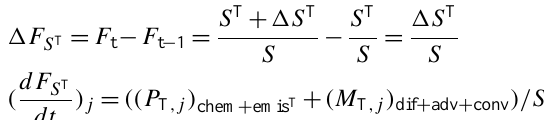
Fig. 1. The three nested domain used for simulation. Left: D1 covers East Asia with 83 × 65 grids; D2 with 61 × 58 grids includes North China; D3 with 79 × 70 grids consists of Beijing and its surrounding cities. Right: source tagged regions: Beijing (BJ); Tianjin (TJ); Tangshan and Qinhuangdao (TQ); Chengde (CD); Zhangjiakou (ZJK); Baoding (BD); Langfang (LF); Shijiazhuang and Hengshui (SH); Cangzhou (CZ); Xingtai and Handan (XH); Xilinguole (XL); Chifeng (CF); Shandong (SD); Middle Shanxi (MSX); Northern Shanxi (NSX).